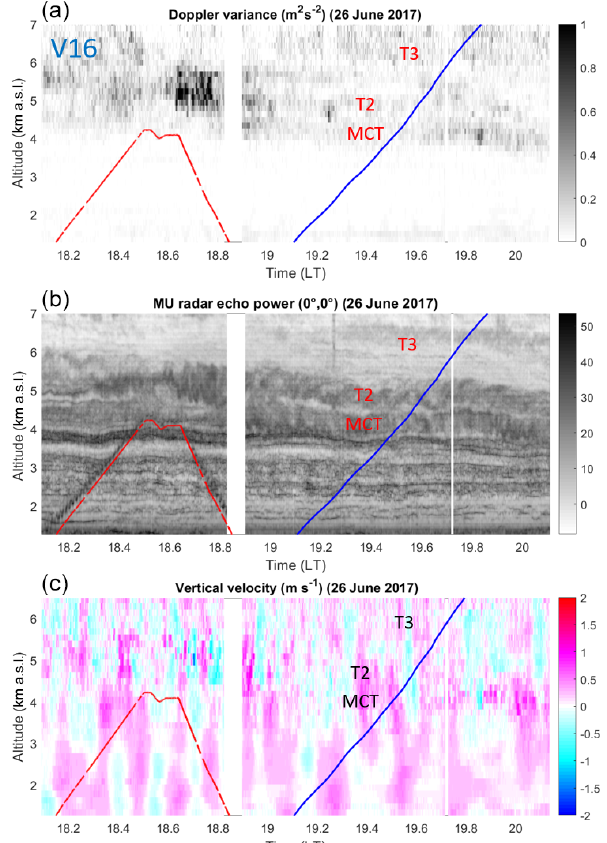
Figure 3. Same as Fig. 2 for SH31 and V16.